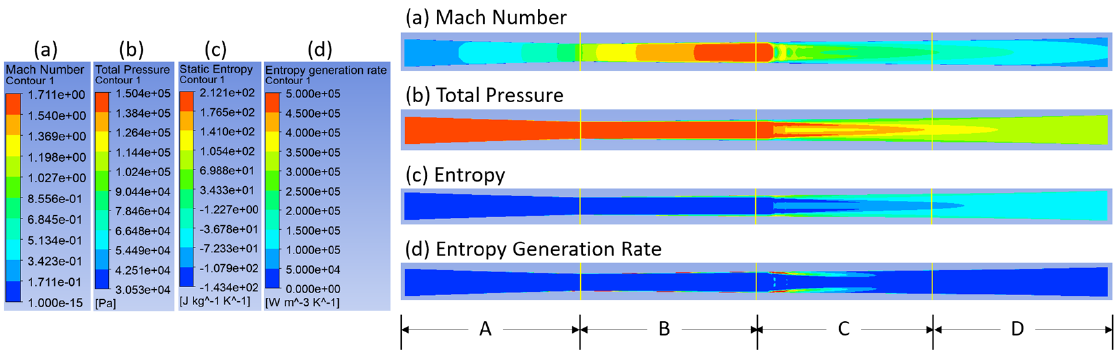
Figure 3. Grid independence with respect to overall entropy generation.